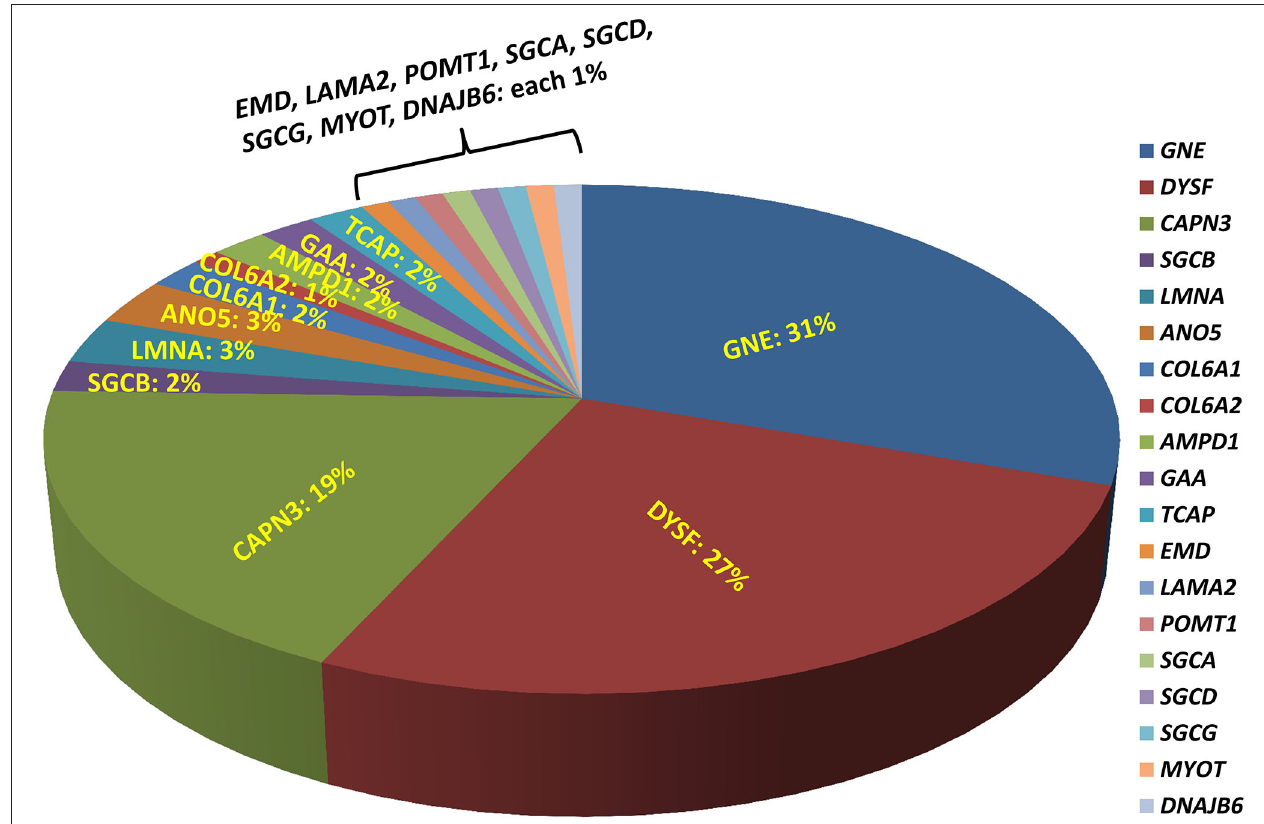
FIGURE 1 | Molecular diagnosis with different genetic myopathy subtypes. Molecular diagnosis using exome sequencing has been established in 49% of the patients with the majority having pathogenic variants identified in one of the following genes: GNE (31%), DYSF (27%), CAPN3 (19%), indicating that these genes are likely the major contributors to genetic myopathy-like